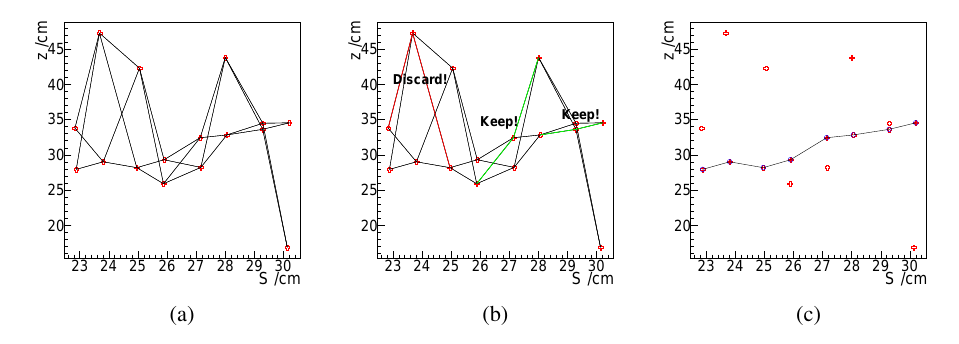
Figure 5: The isochrone center positions plotted in the ( S , z ) space. Figure 5a shows all possible connections between adjacent stereo layers in the STT. In fig. 5b, connections with θ < 90 ◦ are rejected. Finally, fig. 5c shows the selected path after minimising the cost function eq.